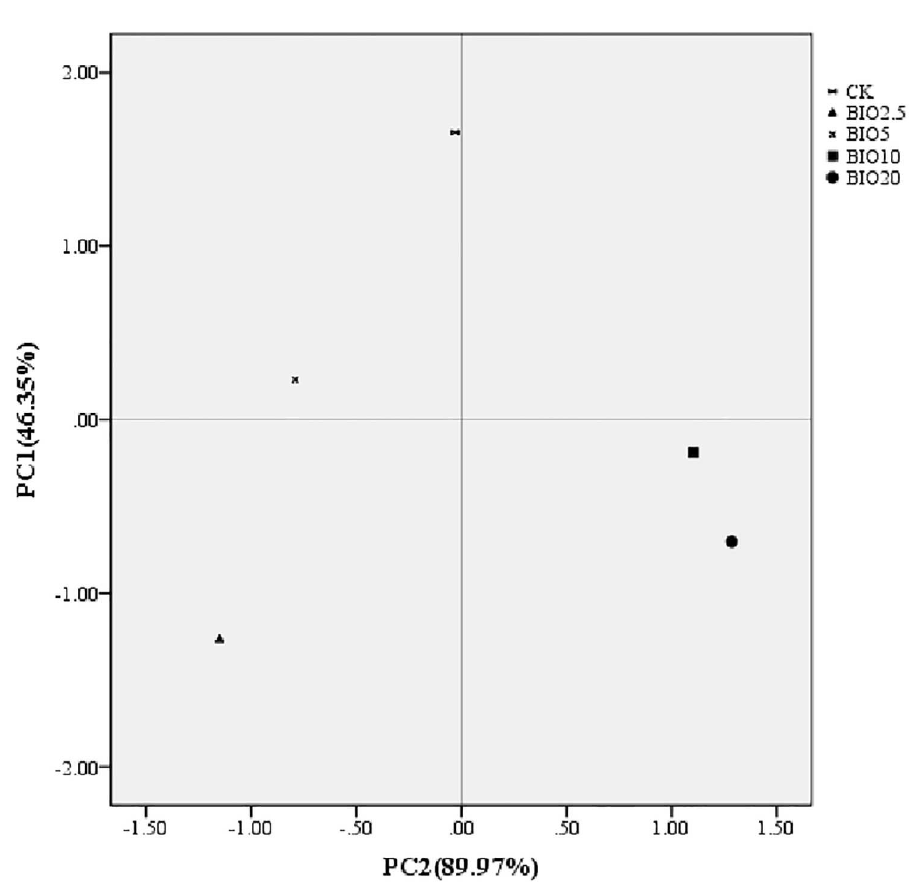
Fig 6. Principal component analysis based on the carbon source utilization pattern of the soil bacterial communities in all samples over a 4-day incubation at 25˚C.